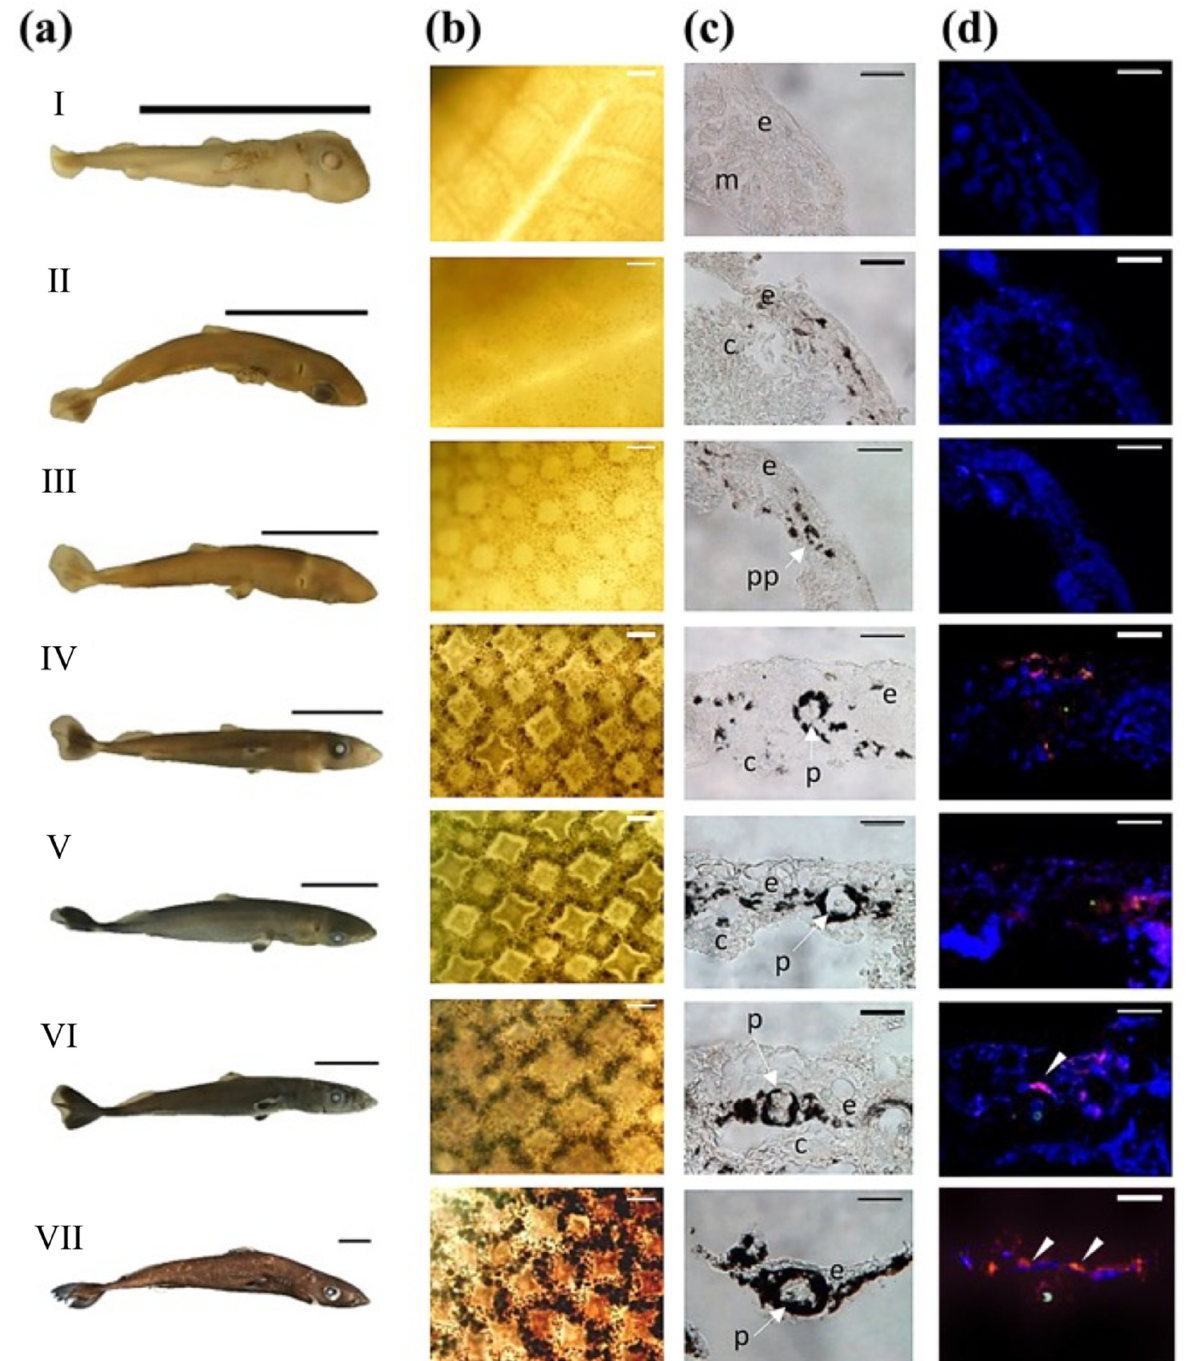
Figure 2. Skin pattern, photophore morphogenesis, and encephalopsin labeling during Squaliolus aliae embryogenesis. ( a ) Developmental stages (stage I to VI: embryonic stage; stage VII: adult). ( b ) Scales and photophore development on ventral skin. ( c ) Photophore morphogenesis visualization on ventral skin cross sections. ( d ) Encephalopsin immunolabelling during the photophore morphogenesis. Green autofluorescence corresponds to maturated vesicles within the photocyte, blue staining corresponds to DAPI nucleus labeling, and red labeling (white arrowhead) corresponds to the encephalopsin immunoreactive site. Scale bars: ( a ) 2 cm, ( b ) 200 µm, and ( c , d ) 100 µm. c: Connective tissue; e: epidermis; m: muscle; pp: protophotophore; p: photophore.